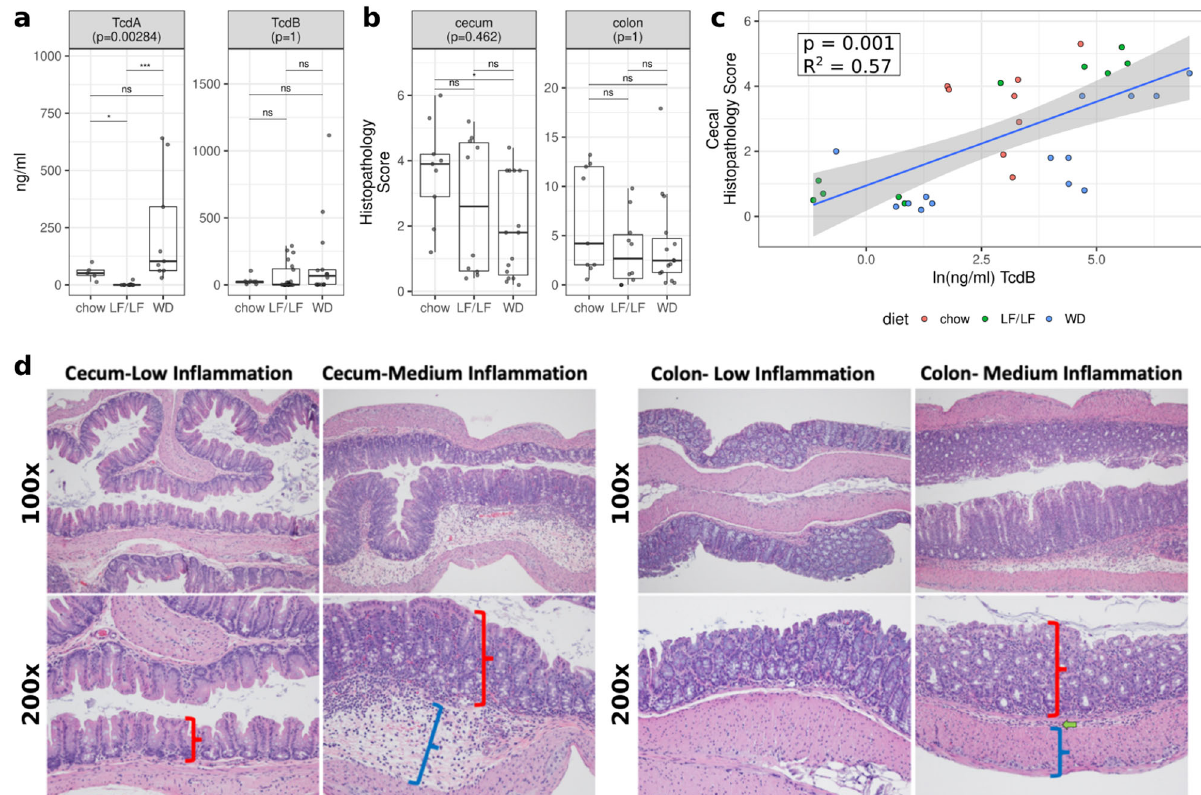
Fig. 2 Toxin and histopathology scores by diet. a TcdA and TcdB production across diets as determined by ELISA. b Histologic in fl ammation scores across diets as determined by a blinded histologist. Signi fi cant differences were calculated with a Kruskal – Wallis and Dunn ’ s post hoc test. Kruskal – Wallis p -values were corrected for multiple comparisons with the FDR algorithm of Benjamini and Hochberg 83 . Also, see Supplementary Fig. 2 for statistical analysis with linear modeling that controlled for batch. Median and Interquartile Range (IQR) indicated. (* p < 0.05, ** p < 0.01, *** p < 0.001, **** p < 0.0001). c Linear regression of cecal histopathology against C. dif fi cile TcdB burden. ( p = 0.001 with model cecum_in fl ~TcdB and FDR correction). d Example sections of cecal (left) and colon (right) tissues with low or medium in fl ammation. No samples had levels of in fl ammation considered to be high. The cecum was scored for injury according to the system of Barthel et al. 2003 24 . Scoring of in fl ammation using the Barthel scoring system is restricted to neutrophils in the mucosa portion of the cecum. In low cecal in fl ammation, no neutrophils are observed in the mucosa (red bracket) while they are observed with medium in fl ammation. Medium cecal in fl ammation also displayed submucosal edema (blue bracket) that is thought to occur at least to some degree due to the neutrophils present in the submucosa. The colon (right panels) was scored for injury according to the system of Dieleman et al. 1998 23 . This system takes into account the relative quantity of in fl ammatory cells as well as whether they are found only in the mucosa layer (red bracket), are also in the submucosa (green arrow), or are found all the way through the muscularis (blue bracket) and into the peritoneal